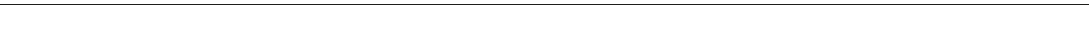
Fig. 5 A time-shift between vector oogenesis and parasite lipid acquisition. a Lipid acquisition by mosquito ovaries precedes P. berghei oocyst development. The ratios of Nile Red mean intensities in the ovaries (orange line, N = 3) and oocysts growth (green line, N = 2) between control and Lp-depleted mosquitoes are shown. Mean oocyst sizes and Nile Red ovary intensities from pooled mosquitoes and experiments ( N ≥ 2, 5 – 13 mosquitoes per time point per condition per experiment). b Lp-depleted mosquitoes ( dsLp ) and controls (Ctrl) were infected with P. berghei and offered ( f – i ) or not ( b – e ) a supplemental blood meal 7 days post infection (dpi) (3 – 63 mosquitoes per condition per experiment). b , f Salivary gland sporozoites were isolated and counted from control and Lp-de fi cient mosquitoes. Each dot represents the mean number of sporozoites per mosquito per experiment ( N = 5; * p < 0.05; one-sided paired t -test, paired values for different dsRNA treatment within the same experiment). c , g Human hepatoma HepG2 cells were infected with 10,000 sporozoites and the number of extra-erythrocytic forms (EEFs) per fi eld was gauged by microscopy 2 dpi. As a negative control, sporozoites from control mosquitoes were treated with cytochalasin D (Cyt D). Five microscopic fi elds were imaged per well per condition in triplicates, except for two cases for dsLp due to the low number of sporozoites. Mean number of EEFs of pooled experiments ( N = 3) and SEM are shown (*** p < 0.0001; Kruskal – Wallis test and Dunn ’ s multiple comparison test). d , h Representative fl uorescent micrographs of GFP-expressing EEFs (green) developing in HepG2 cells. Cell nuclei are stained with DAPI (blue). Scale bar — 10 µ m. e , i Growth of EEFs produced by sporozoites from control and Lp-de fi cient mosquitoes. EEFs sizes of pooled experiments are shown ( N = 3). The boxplots show the median (center line), the 25th to 75th percentiles (bounds of box) and the 10th and 90th percentiles (whiskers). The total numbers of EEFs are shown in brackets. e *** p < 0.0001; i p = 0.4223; one-sided Mann – Whitney